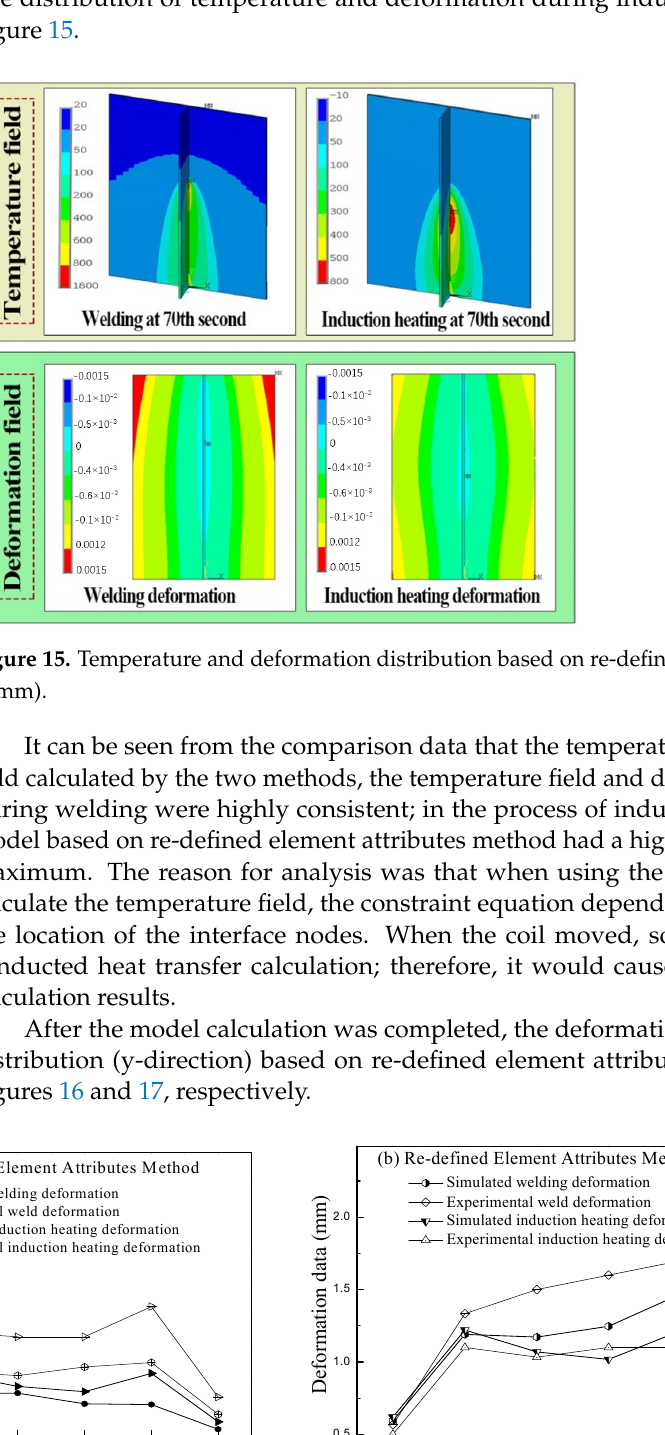
ment, and then change a small amount of element attributes at different load steps accord-